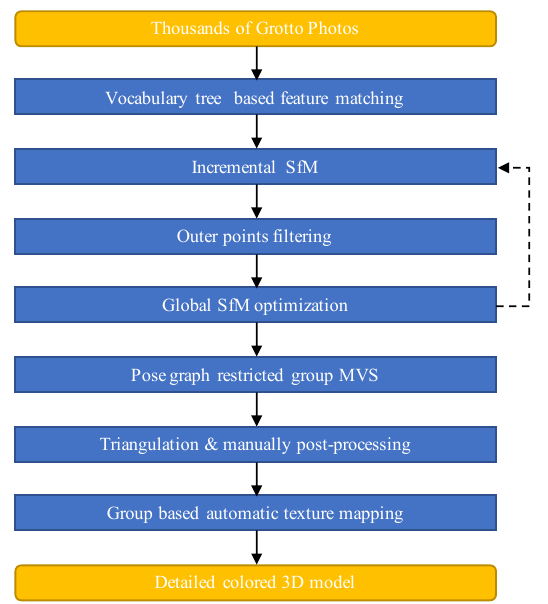
Figure 3. The basic photogrammetry pipeline for large